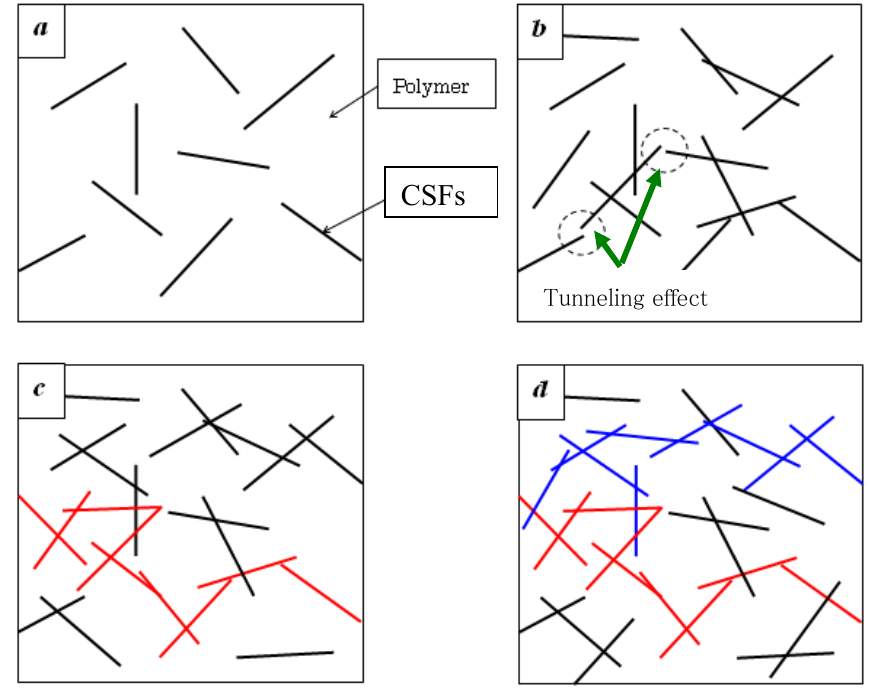
Figure 1. Percolation process in conductive